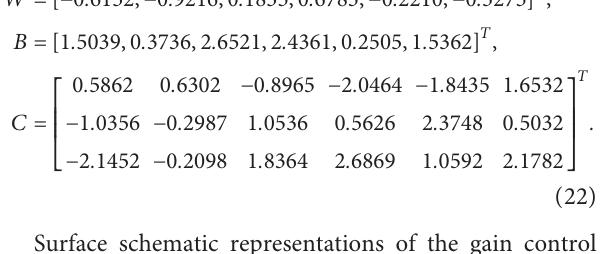
Surface schematic representations of the gain control parameters comprising K P , K I , and K D are shown in Figure 6. The contact constant force is loaded as 10 N , and the response curves of two control strategies are shown in Figure 7. The constant force traction error in the stability interval (1.5–10 s) is shown in Figure 8. As shown in Fig- ures 7 and 8, the response time of the complete tracking process in 1.5 s and the maximum traction error is 0.22 N. The parameters of the FNN-PID controller are self-adjusted; therefore, the response speed improved and the constant force tracking process is more stable. While maintaining constant force control, simulation comparisons of the displacement trajectory tracking